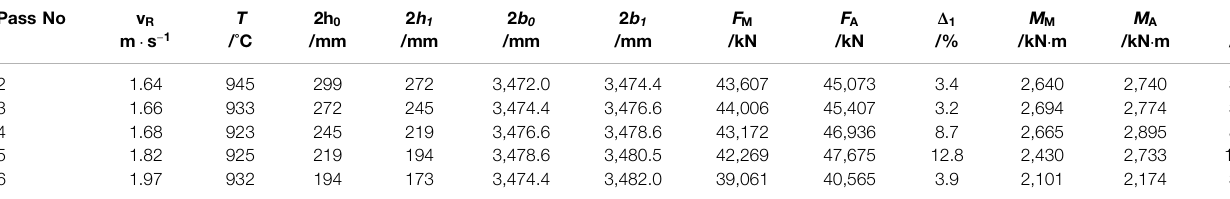
TABLE 1 | Validation of the predictive models of rolling force and torque with measured data.